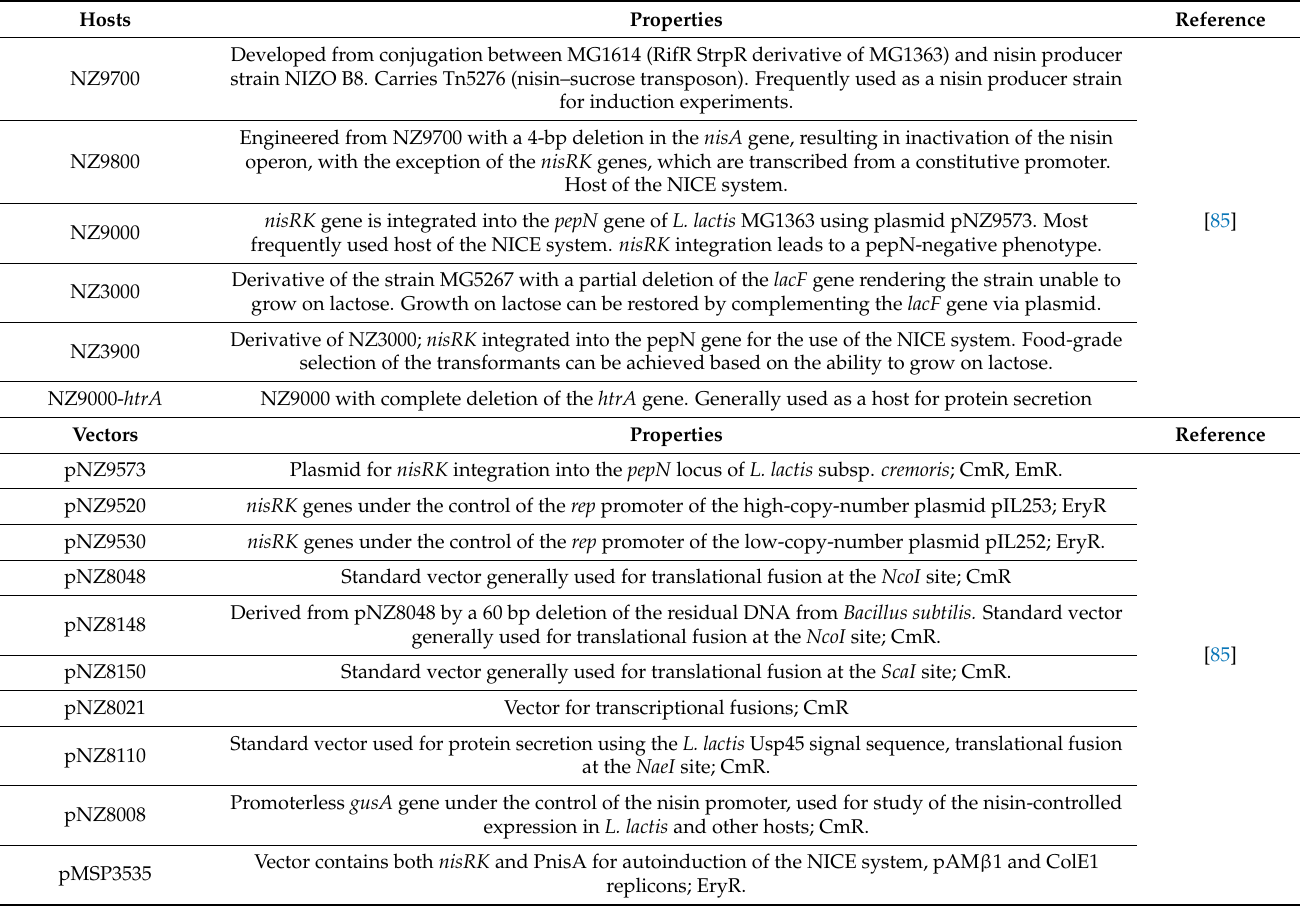
Table 2. Host and vectors engineered for the development of the NICE